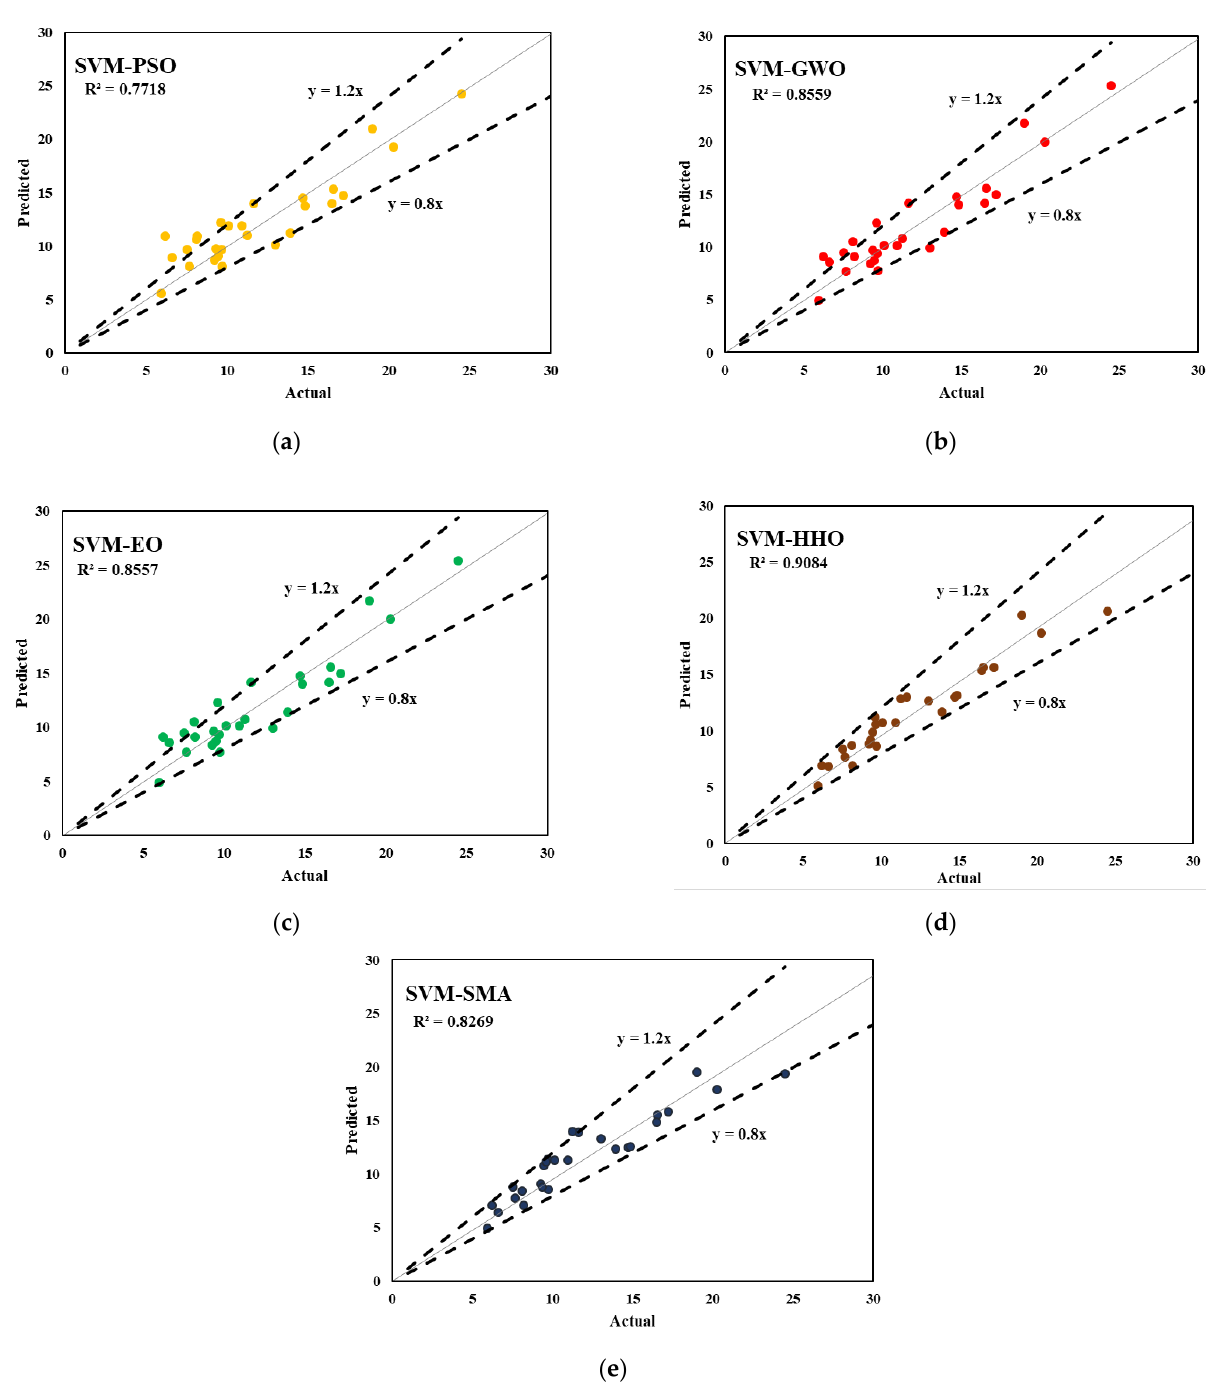
Figure 6. Actual vs. predicted graphs for the testing dataset; ( a ) SVM-PSO ( b ) SVM-GWO ( c ) SVM-EO ( d ) SVM-HHO ( e ) SVM-SMA. Table 6. Performance indices for the training dataset.